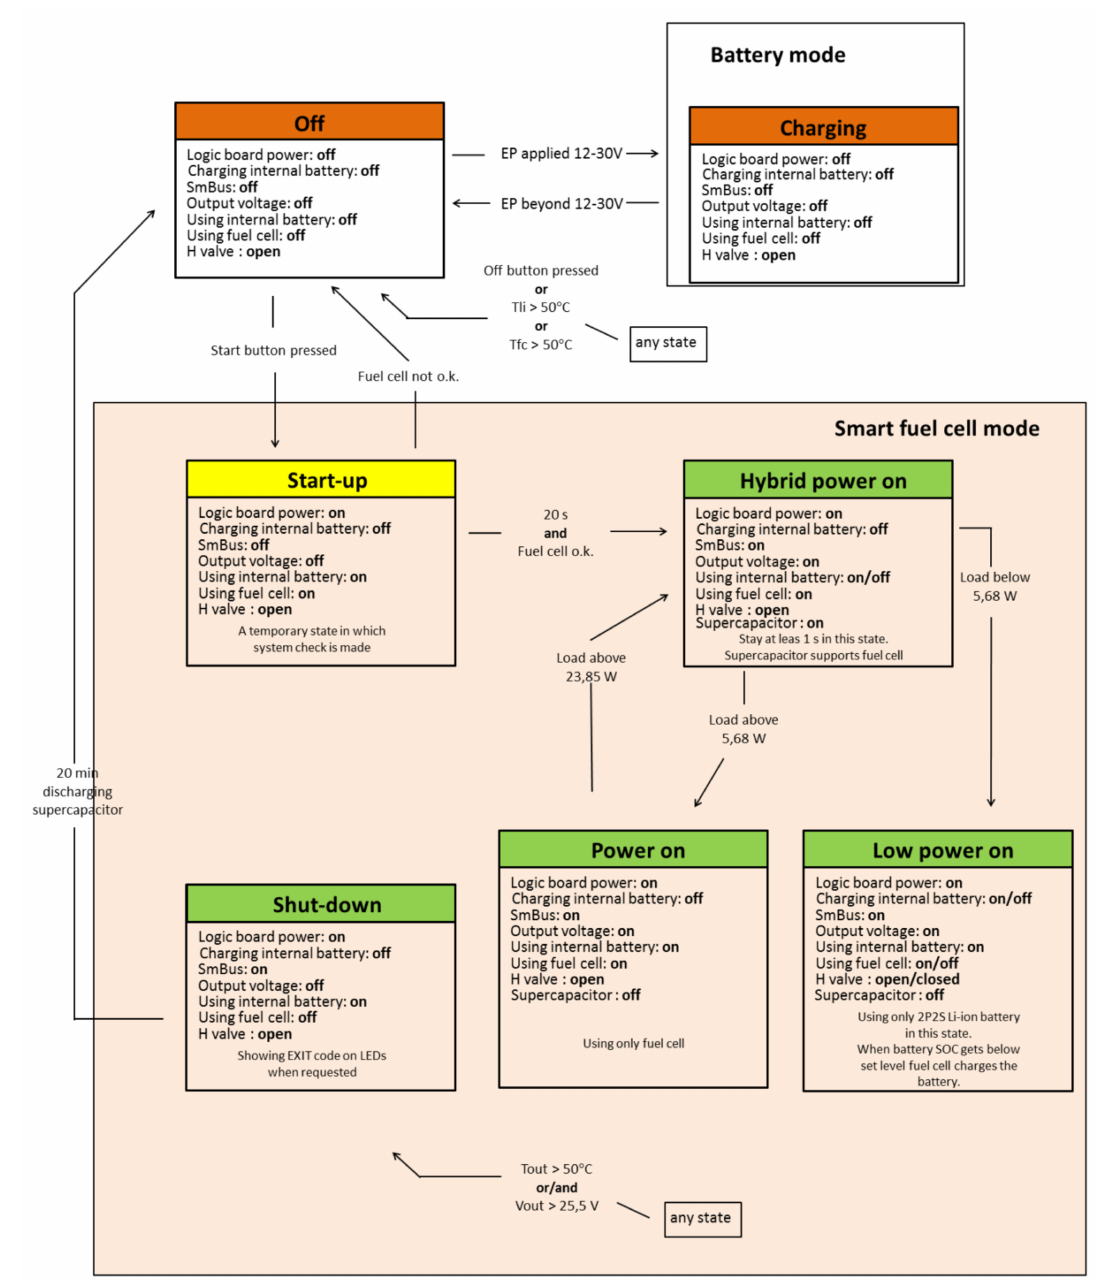
Figure 8. Physical model control